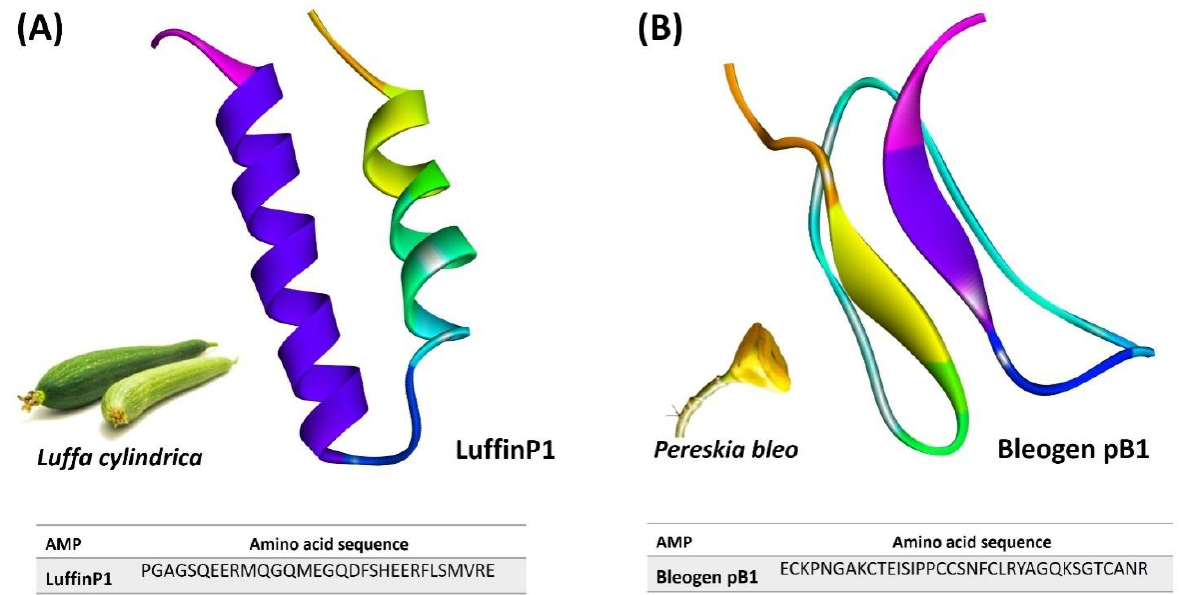
Figure 5. Selected α -Hairpin-like peptide ( A ) and hevein-like peptides ( B ) that have potential antimicrobial activities for food preservation: LuffnP1 (PDB ID: 2L37) and Bleogen (PDB ID: 5XBD).